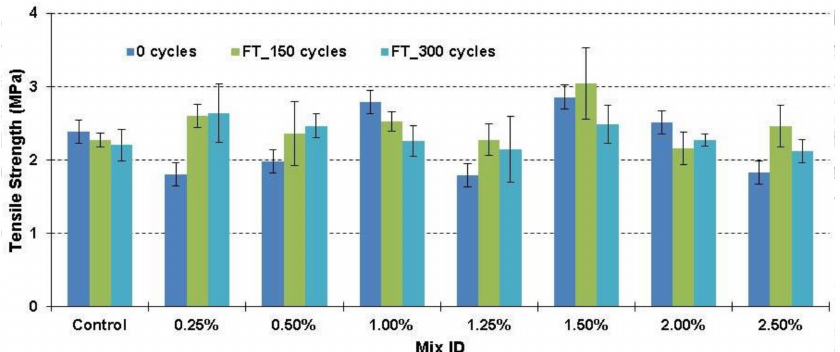
Figure 8. Tensile strength results due to freeze and thaw cycles.